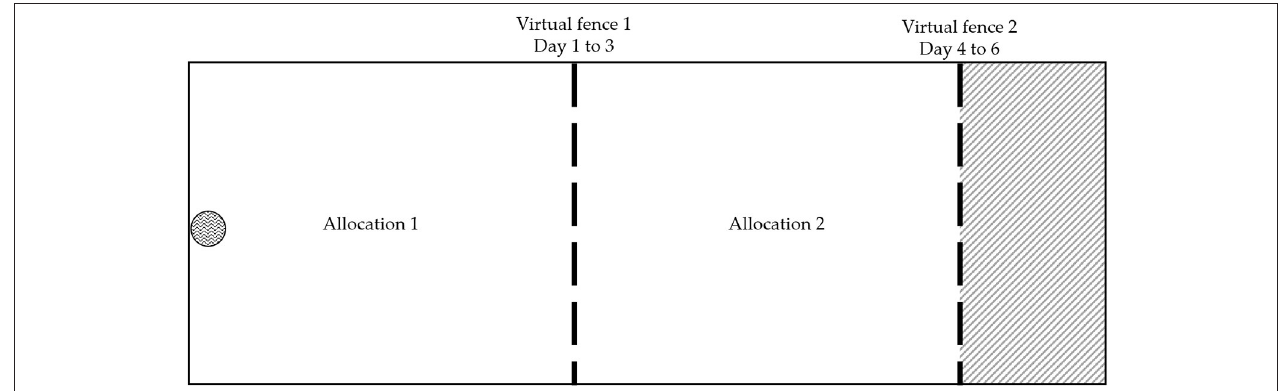
FIGURE 2 | Diagrammatic representation (not to scale) of the training paddock used to train dairy cows in each block before experimental work, similarity seen in Lomax et al. (2019). The paddock was divided into three sections. Allocation one (A1) with the virtual fence (VF) 1 was allocated for days 1–3. At the end of day three the VF was moved forward to the VF 2 to allow dairy cows access to A1 and A2. The third section (grey shaded area) remained unallocated, as it was the exclusion zone for days 4–6. The water trough is